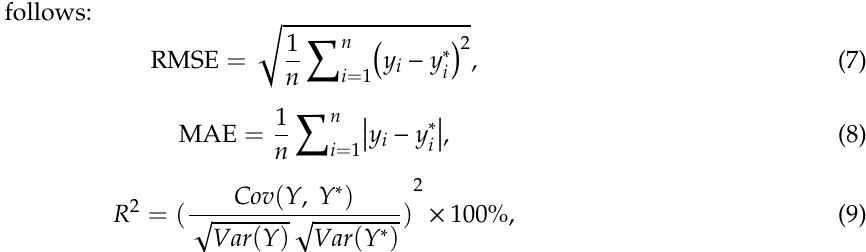
Table 1. Limited by ECMWF data, only PM 2.5 observations at 02:00, 08:00, 14:00, and 20:00 (BJT)